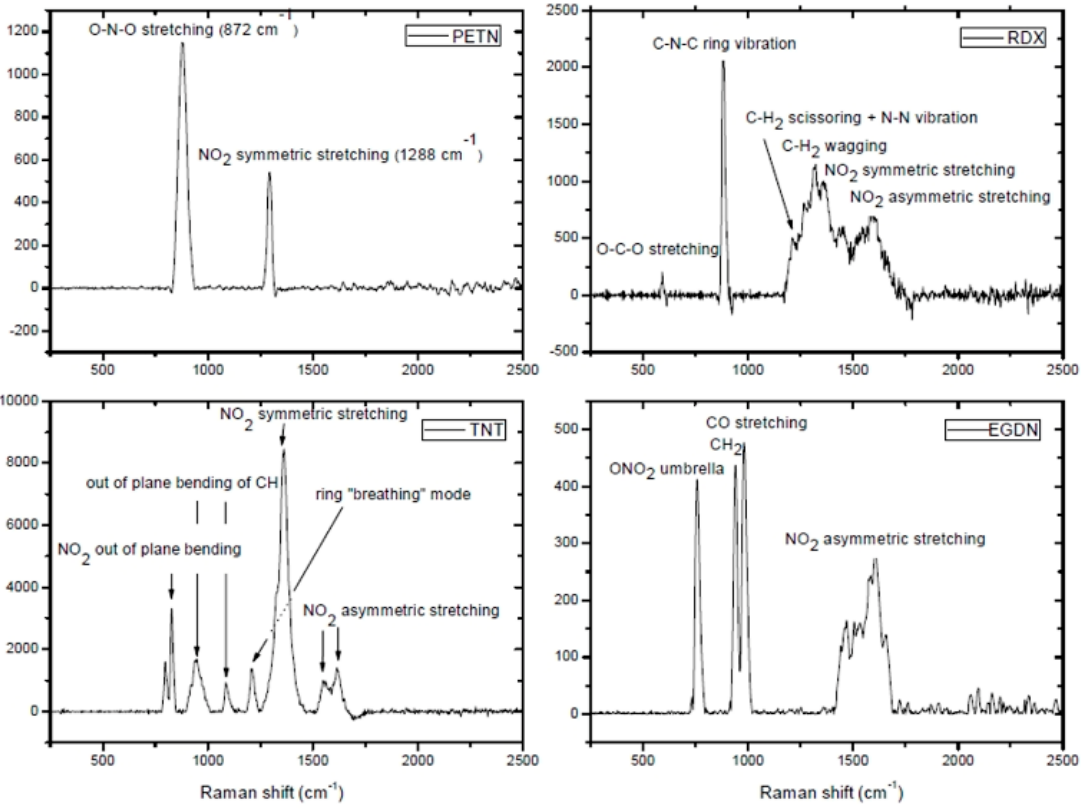
Figure 11. Surface-enhanced Raman spectra of PETN, RDX, TNT, and EGDN. Adapted from [112], with permission from © 2012 SPIE.